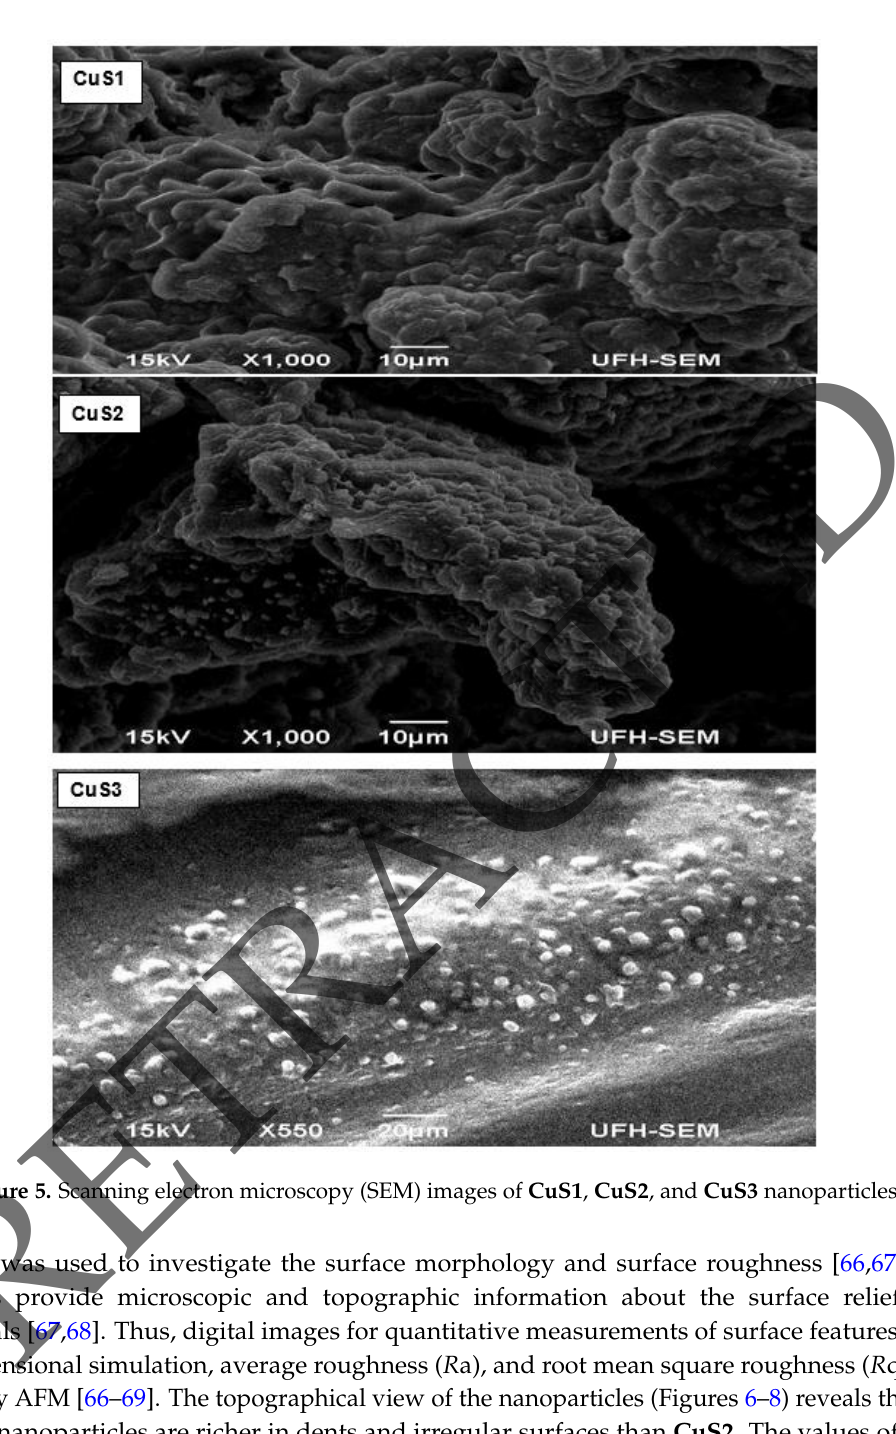
Figure 5. Scanning electron microscopy (SEM) images of CuS1 , CuS2 , and CuS3 nanoparticles.